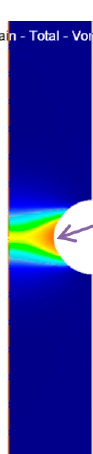
Figure 20. Comparison of forces for plane strain test.